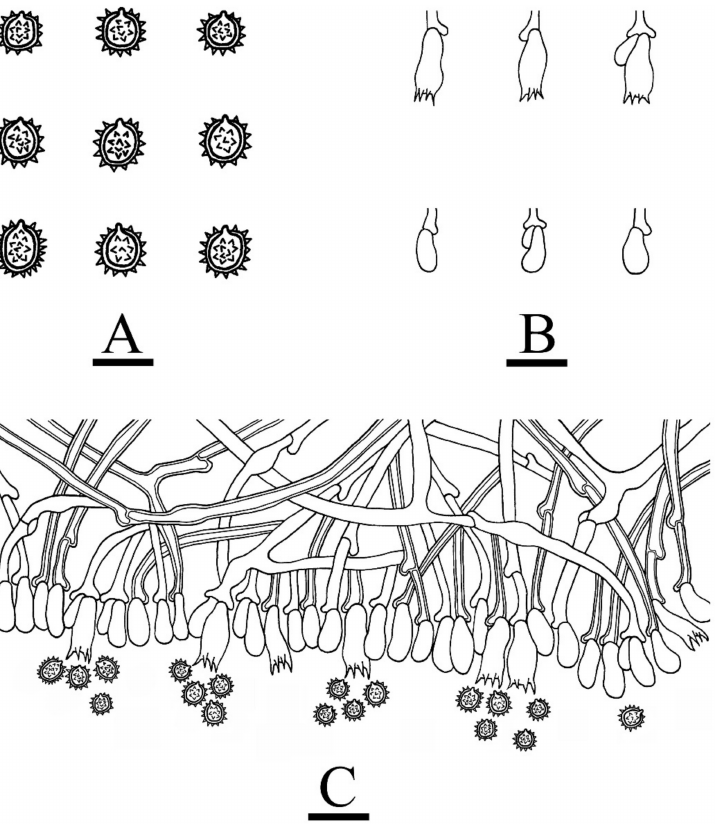
Figure 8. Microscopic structures of Trechispora olivacea (holotype CLZhao 17826): basidiospores ( A ), basidia and basidioles ( B ), a cross-section of basidiomata ( C ). Bars: ( A ) = 5 µ m, ( B , C ) = 10 µ